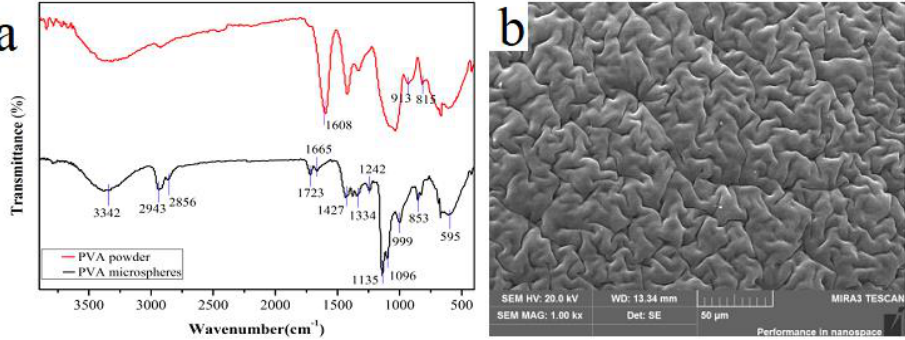
Figure 1. Characterization of PVA microsphere: (( a ): the infrared spectrogram of PVA powder and PVA microsphere; ( b ): scanning electron microscope of PVA